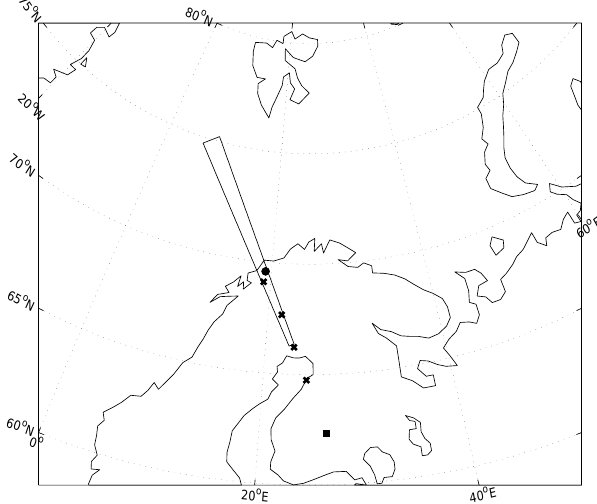
Fig. 1. Map of the instruments used and their fields-of-view. The square denotes the CUTLASS Hankasalmi radar. The box repre- sents the field-of-view of channel A (beam 5). The circle denotes the EISCAT UHF radar and EISCAT HF facility. The crosses indi- cate the UHF radar scan positions at an altitude of